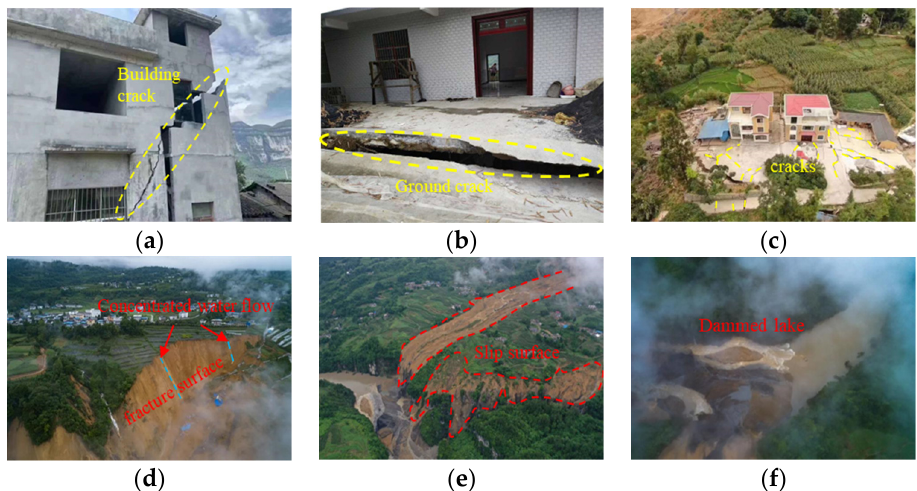
Figure 8. Damages caused by the Shaziba landslide: ( a ) cracks in the building; ( b ) ground cracks; ( c ) cracks near the houses; ( d ) main scarp of the landslide; ( e ) slip surface; ( f ) dammed lake.